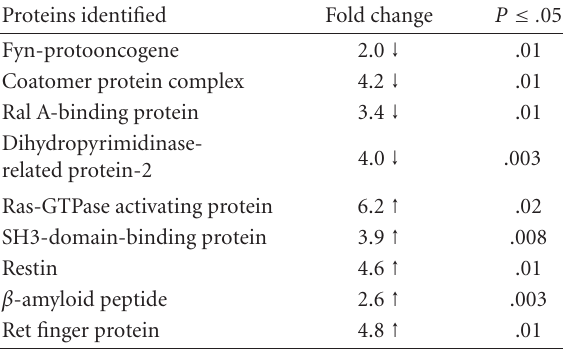
Table 1. Proteins di ff erentially expressed in response to WNV infection. Statistical analysis (Student’s t test) was done to deter- mine the significance of the di ff erential protein expression ob-